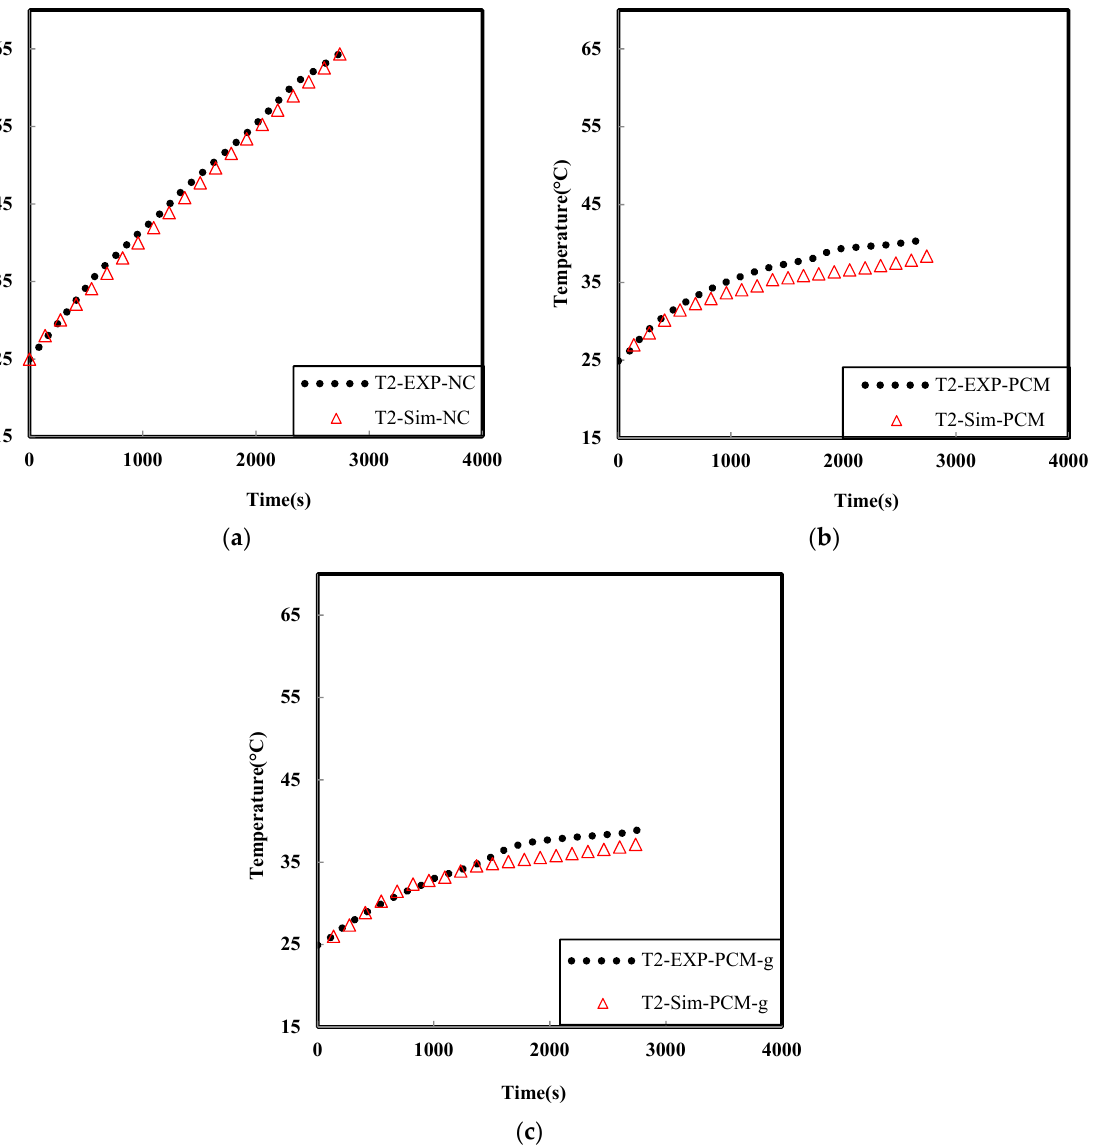
Figure 7. Thermal model validation of the module ( a ) under natural convection, ( b ) PCM, and ( c ) PCM-graphite at a 1.5C discharging rate (Sim: Simulation, NC: Natural convection, PCM-g: PCM-graphite.